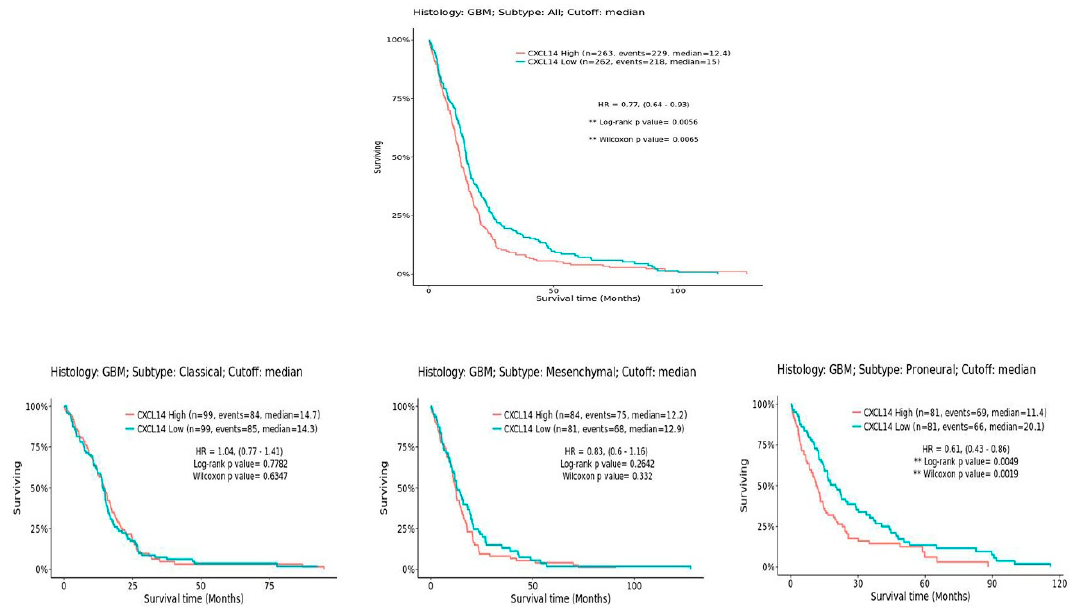
Figure 8. CXCL14 expression inversely correlates with overall survival in glioblastoma. On the left, a comprehensive graph shows the overall survival of all glioblastoma patients in the TCGA dataset, as analyzed by GlioVis (http://gliovis.bioinfo.cnio.es/) [25]; on the right, three distinct graphs were generated by separately analyzing GBM patients based on the subtypes of their tumors.